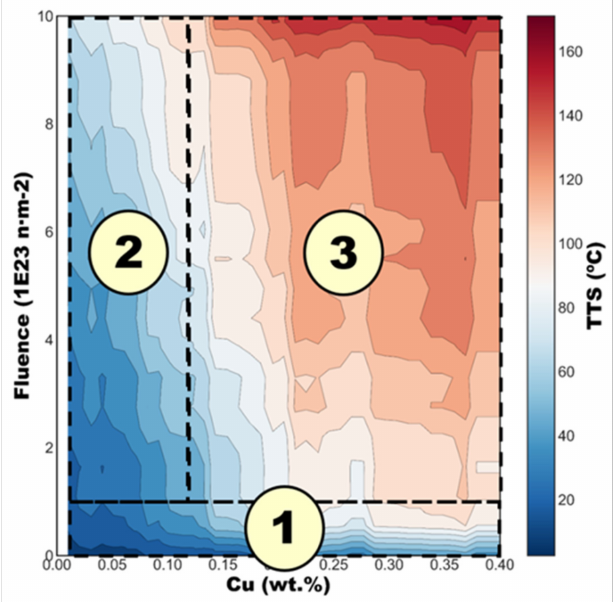
Figure 13. D Interaction plots between the two most relevant features, Cu and